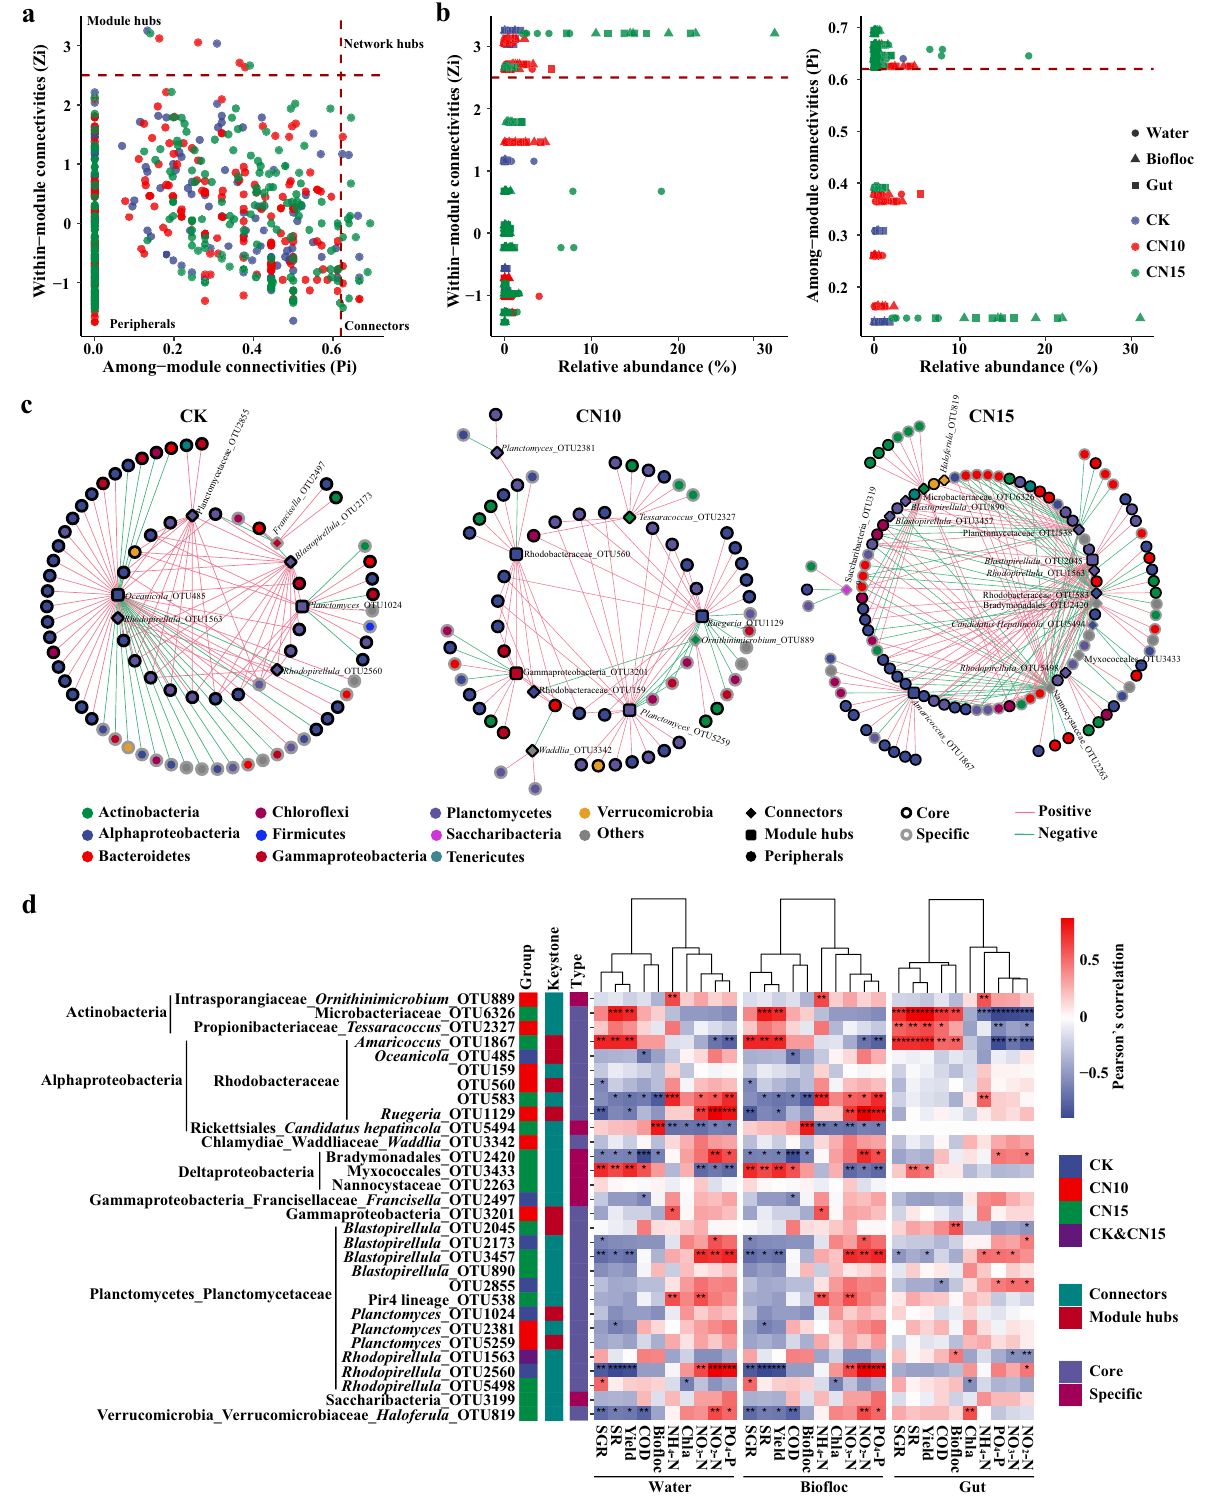
Fig. 5 Identifying the keystone taxa of each bacterial networks and their associations with water quality and shrimp growth parameters. Keystone taxa ( a ) and their relative abundances ( b ) in bacterial communities of CK ( n = 12), CN10 ( n = 18) and CN15 ( n = 18) groups. c The relationships of keystone OTUs and the OTUs they recruited in CK ( n = 12), CN10 ( n = 18) and CN15 ( n = 18) groups. d Pearson ’ s correlation analysis between keystone OTUs, water quality parameters, bio fl oc volume and shrimp growth performance. NH 4 -N, ammonium-N; NO 2 -N, nitrite-N; NO 3 -N, nitrate- N; PO 4 -P, phosphate-P; COD, chemical oxygen demand; Chl-a, Chlorophyll a; SR, survival rate; SGR, speci fi c growth rate; Yield, total yield of shrimp each pond. Different asterisks indicate a signi fi cant difference at * p < 0.05, ** p < 0.01, and *** p < 0.001 in ( d ) based on Student ’ s t test. CK: without sucrose addition; CN10: the C/N ratio of about 10:1 obtained by sucrose addition; CN15: the C/N ratio of about 15:1 obtained by sucrose